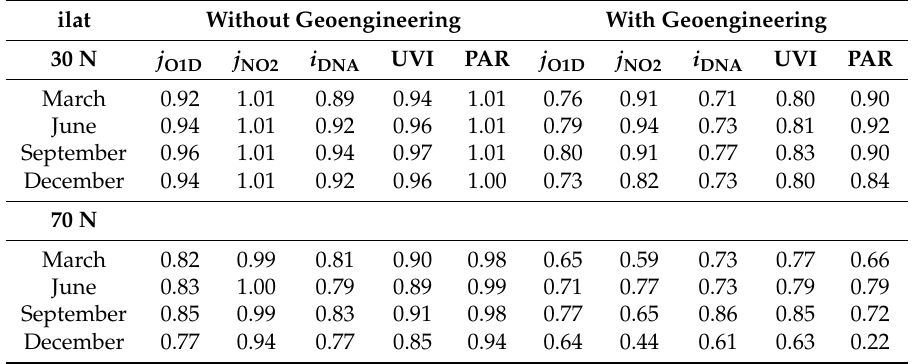
Table 3. Future changes in surface photochemical ( j O1D and j NO2 ) and photobiological ( i DNA , UVI, and PAR) radiation, as ratios of values in 2080 to 2020, with and without geoengineering by stratospheric SO 2 injections. Based on daily average values for the months indicated. ilat Without Geoengineering With Geoengineering 30 N j O1D j NO2 i DNA UVI PAR j O1D j